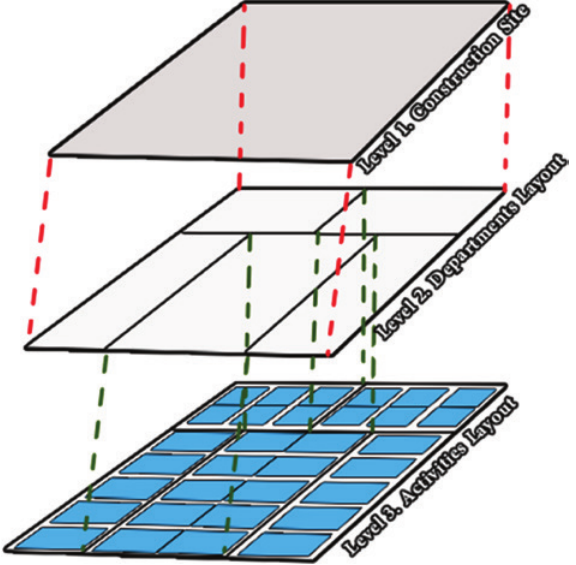
Figure 1: Three-Level FLP Approach.